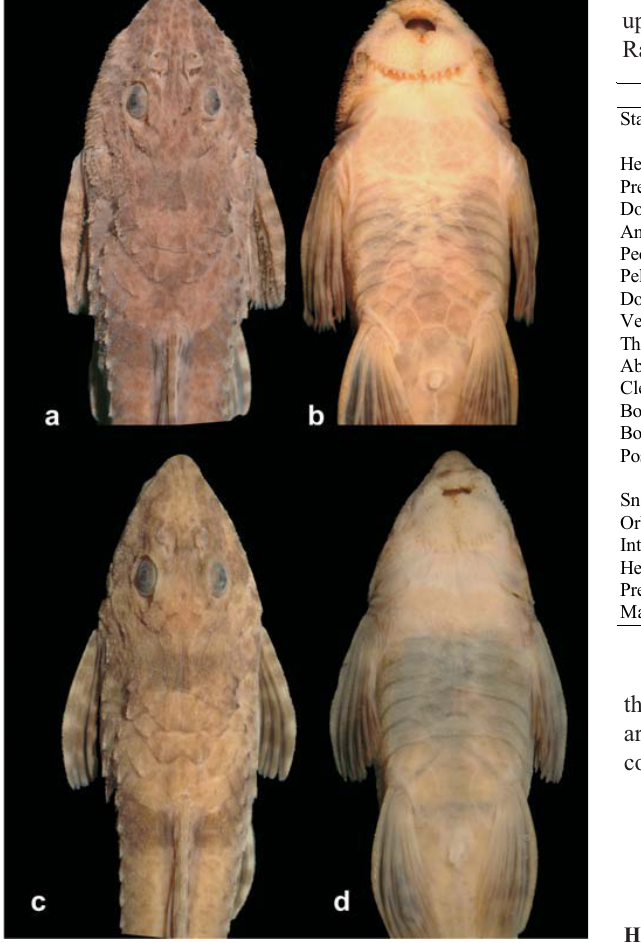
Fig. 2. Sexual dimorphism and plate distribution on abdomen and ventral region of pectoral girdle of Rineloricaria langei . a-b : holotype, male, MCP 42506, 114.9 mm SL; c-d : paratype, female, MCP 23459, 89.2 mm SL, rio Iraí, Quatro Barras, Paraná, Brazil.